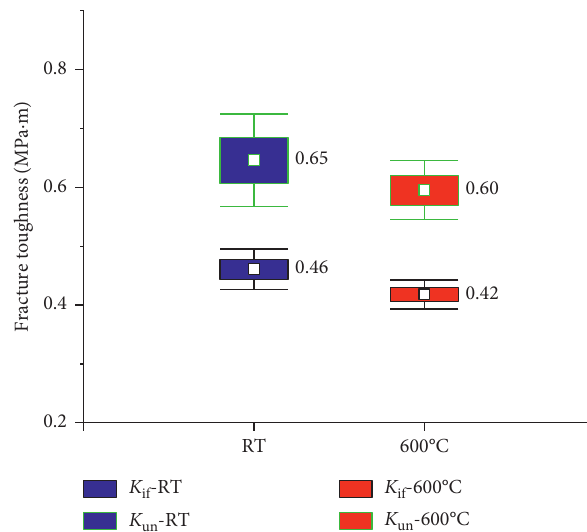
Figure 9: Average fracture toughness (the blue is at room tem- perature; the red line is after treatment at 600 ° C).